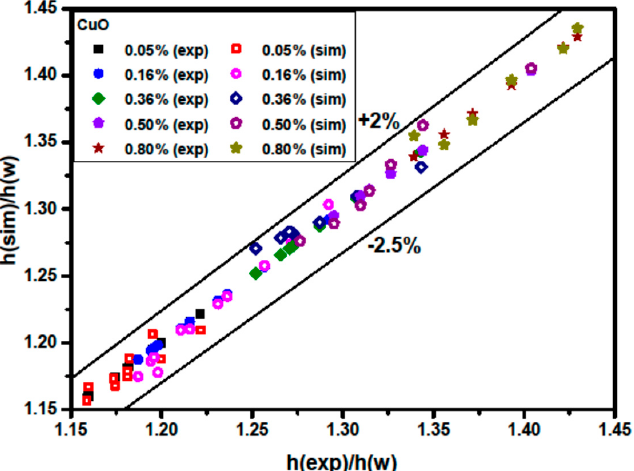
Figure 15. Comparison of the measured and predicted heat transfer coefficient to the water heat transfer coefficient for CuO/water nanofluids.